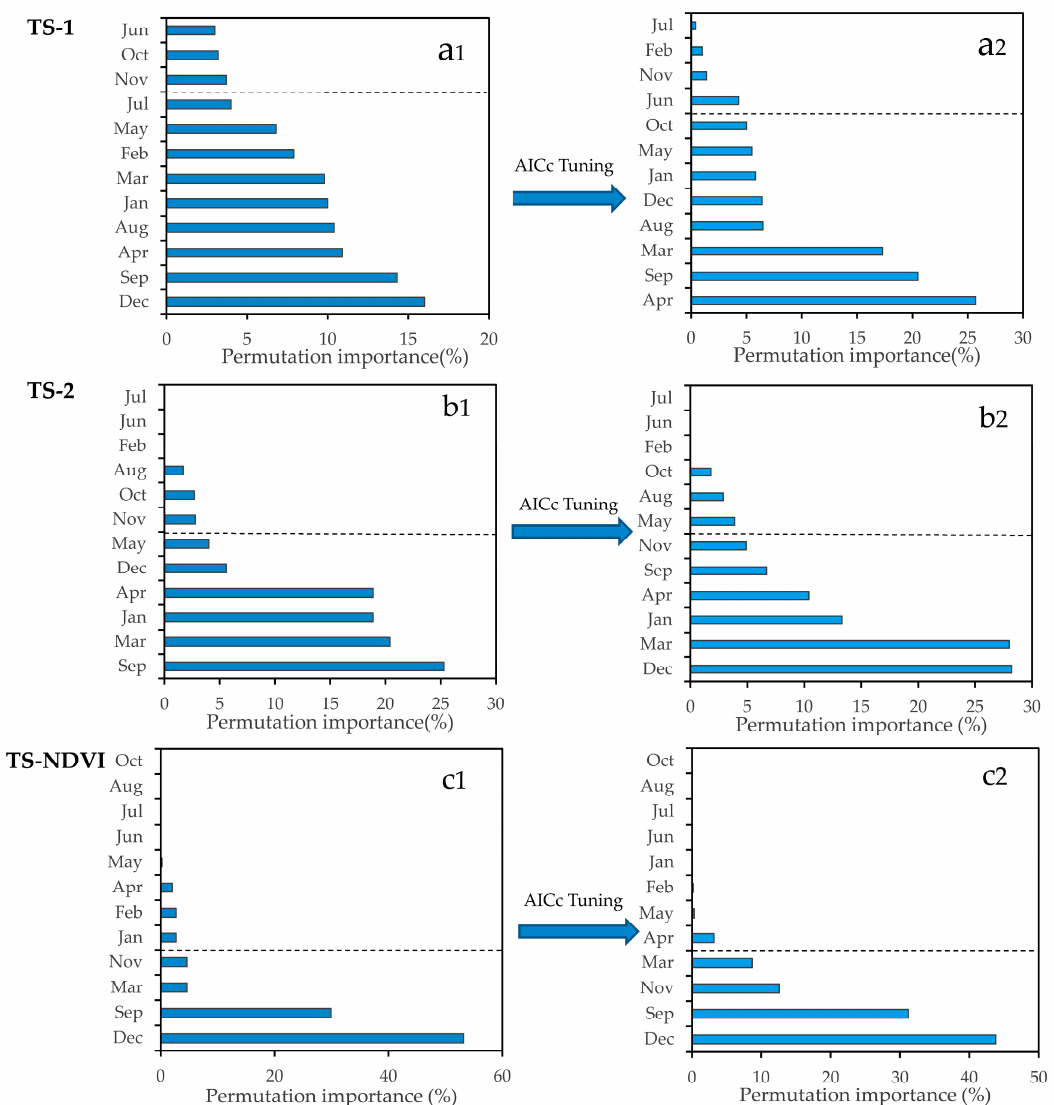
Figure A3. Month’s importance sorted in descending order with the permutation importance value. The month importance was determined by summing the permutation importance value of all bands in each month. ( a ) Months’ permutation importance from the first time-series model (TS-1); ( b ) months’ permutation importance from the second time-series model (TS-2); ( c ) months’ permutation importance from the third time-series model (TS-NDVI). ( a1,b1,c1 ) are Month’s permutation importance from three time-series models with default parameters. ( a2,b2,c2 ) are Month’s permutation importance from three time-series models with AICc-selected parameters. The sum of the permutation importance value from the months with two time-series models exceeds 90% of the total, depicted by the gray dotted line.